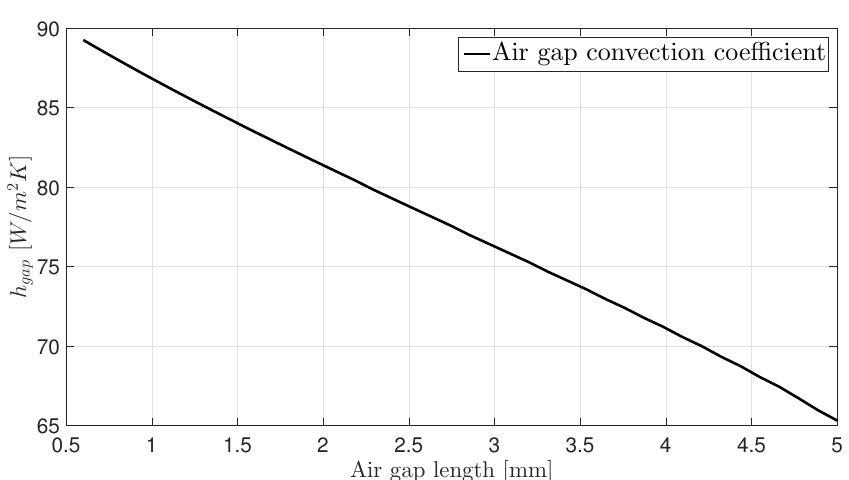
Figure 9. The air gap convection coefficient variation with the air gap length.